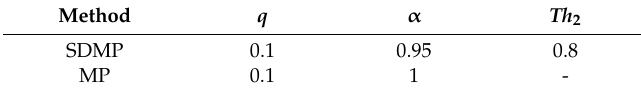
Figure 8. Results obtained by applying SDMP to the simulation signal in a pipe with a small crack: ( a ) the original signal of the propagating guided wave; ( b ) approximated atom 1—the direct signal; ( c ) approximated atom 2—the reflection from the pipe end; and ( d ) approximated atom 3—the reflection from the crack. Table 2. Parameters that were used for approximation of signals obtained from